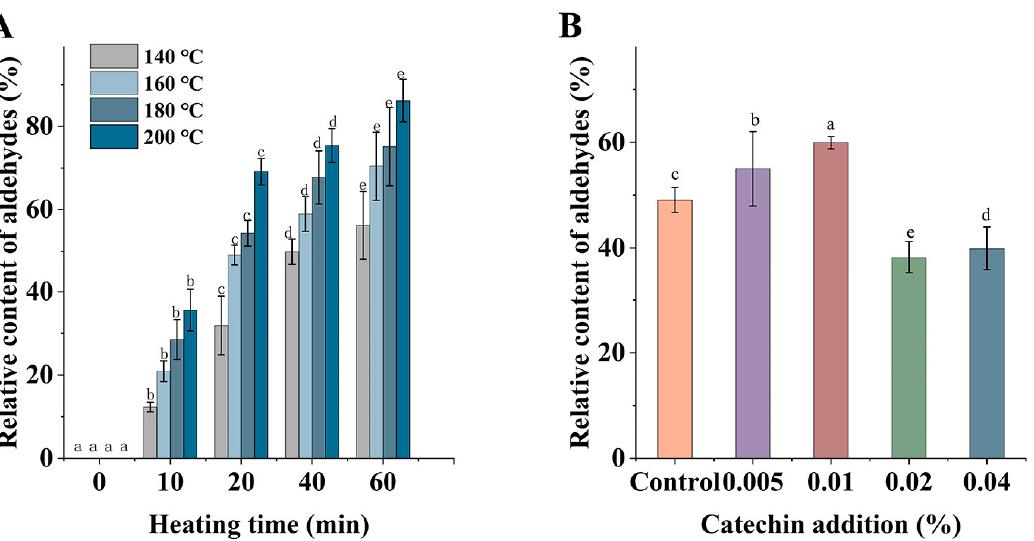
Figure 3. Relative contents of aldehydes in C. oleifera oil under different heating temperatures and times ( A ); Relative contents of aldehydes after adding different catechin addition and heated at 160 °C for 20 min ( B ). Bars with different letters show significant differences ( p < 0.05).